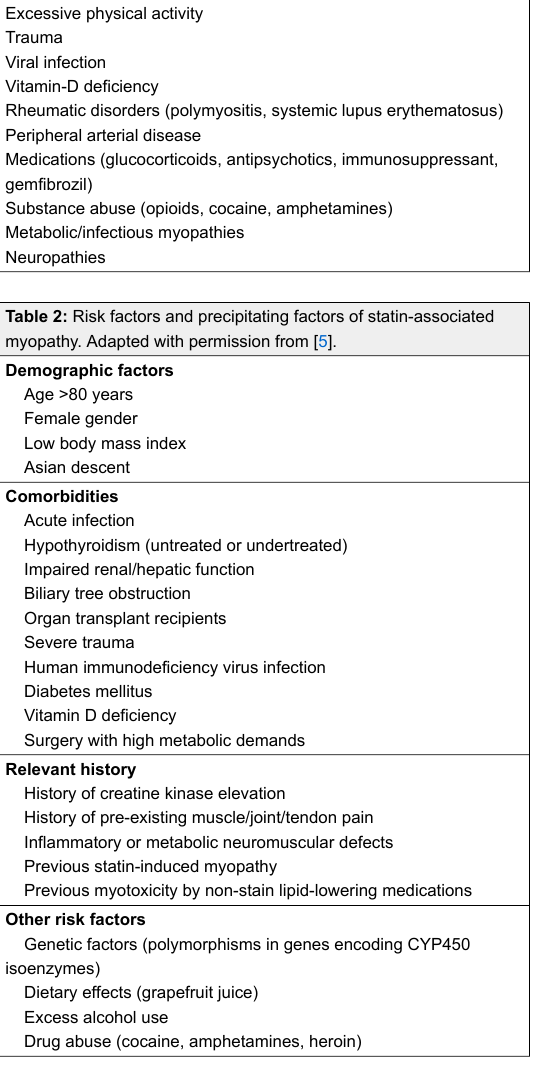
Table 1: Differential diagnosis of muscle symptoms or creatine kinase elevation.